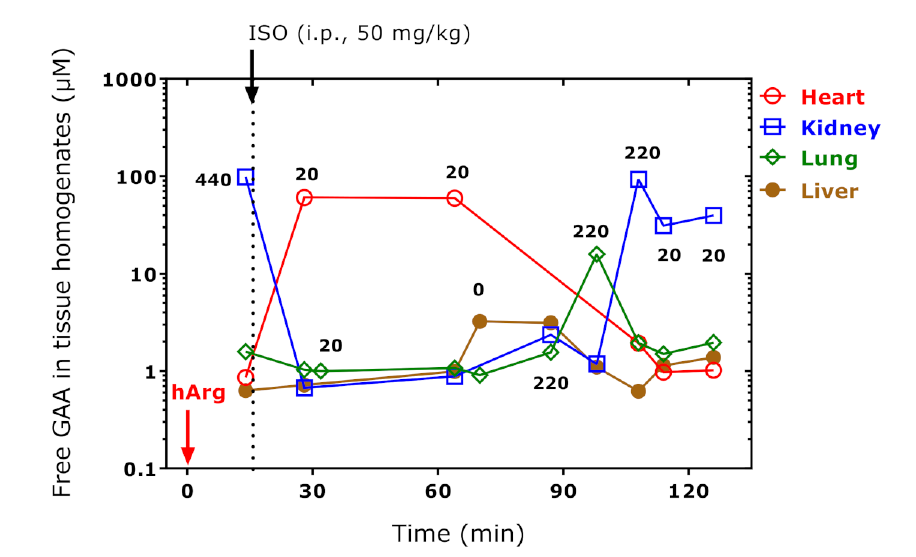
Figure 5. Tissue-free GAA concentration in organ homogenates of the rats. The indicated hArg doses were administered at t = 0 min and the rats were sacrificed at the indicated time points. Isoprenaline (ISO) was administered at t = 15 min. Arrows indicate the administration of hArg and